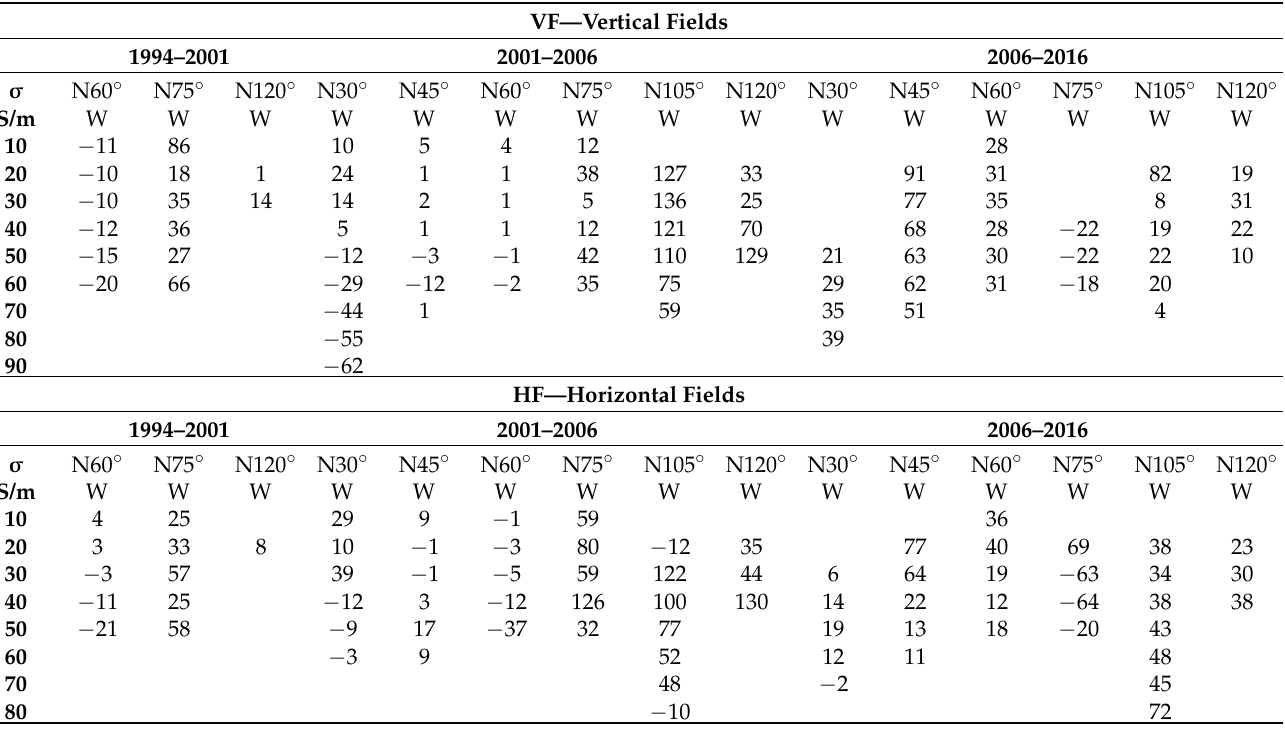
Table 1. Calculated dislocation of the conductivity ( σ ) contouring lines for vertical fields (VF) and horizontal (HF). VF—Vertical Fields